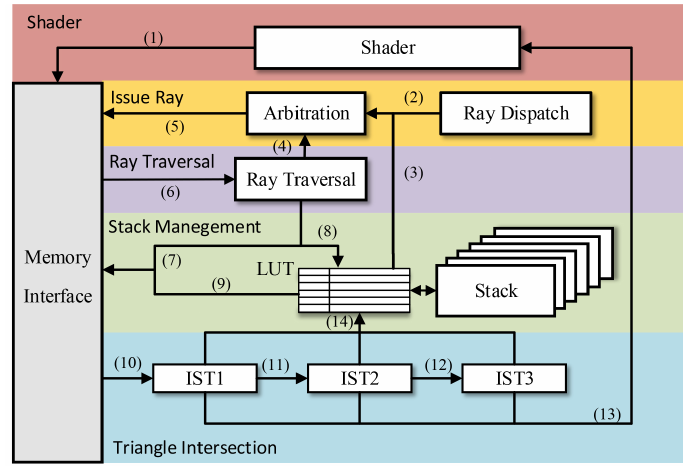
Figure 1. Overall system architecture of RT engine.